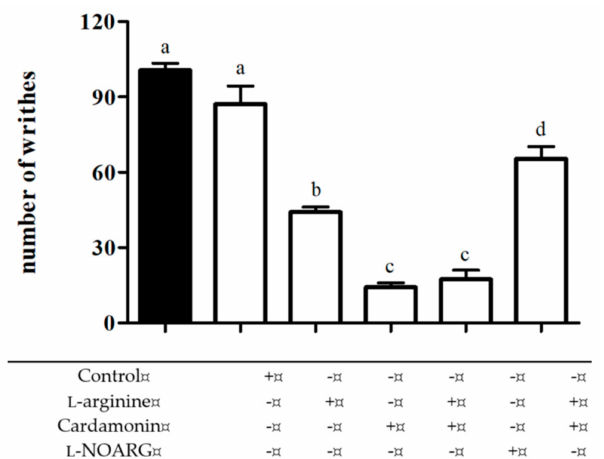
Figure 4. E ff ect of pre-treatment with l -arginine (100 mg / kg; i.p.) on antinociceptive activity of cardamonin (1 mg / kg; i.p.) and l -NOARG (20 mg / kg; i.p.) against acetic acid-induced abdominal writhing test in mice. Each column represents the mean ± S.E.M. of six mice. Statistical analysis was determined by one-way ANOVA, followed by Tukey’s post hoc test. Values with di ff erent superscript letters are statistically di ff erent from each other at p < 0.05.